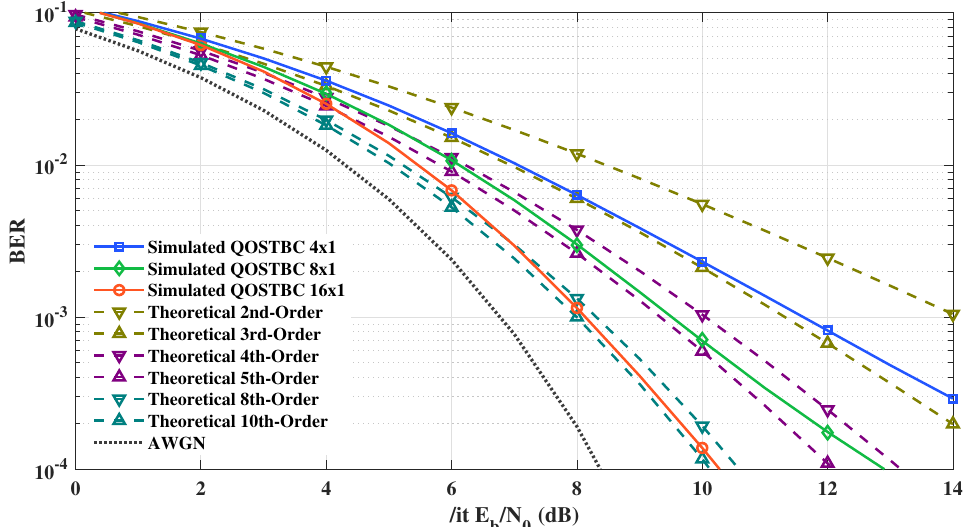
Figure 10. Simulation for the proposed coding scheme against theoretical results for equal bitrate and M T = 4 and 8 with M R = 1 [11].